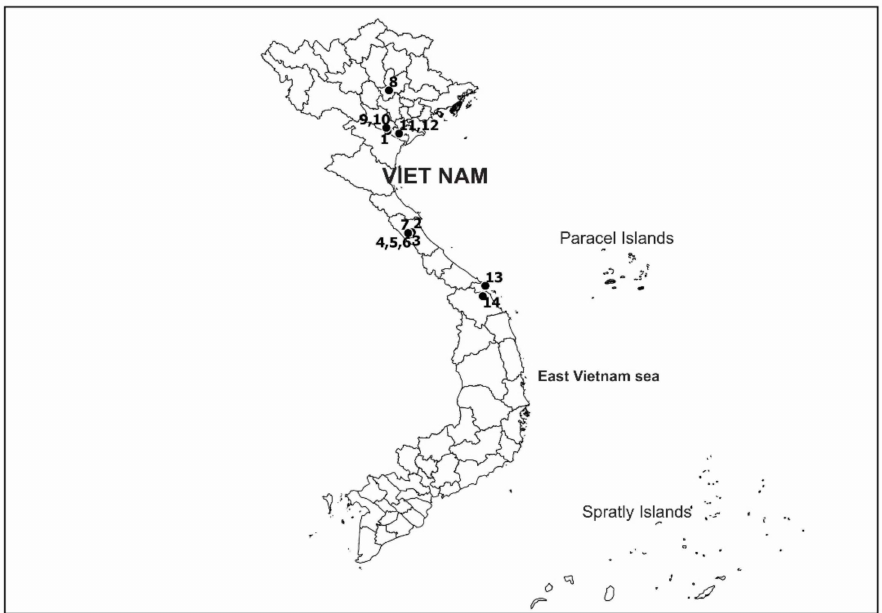
Figure 15. Map showing distribution of: 1. Hadodiaptomus dumonti , 2. Nannodiaptomus phongnhaensis , 3. Nannodiaptomus haii , 4. Bryocyclops anninae . 5. Pseudograeteriella longifurcata , 6.